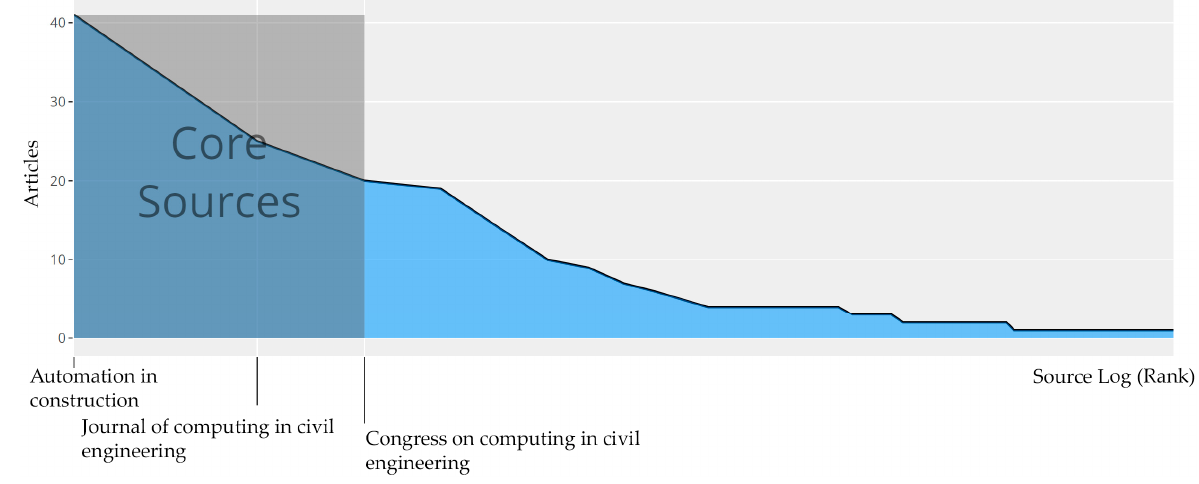
Figure 14. Bradford’s Law plot. Software: BiblioShiny version 3.0.